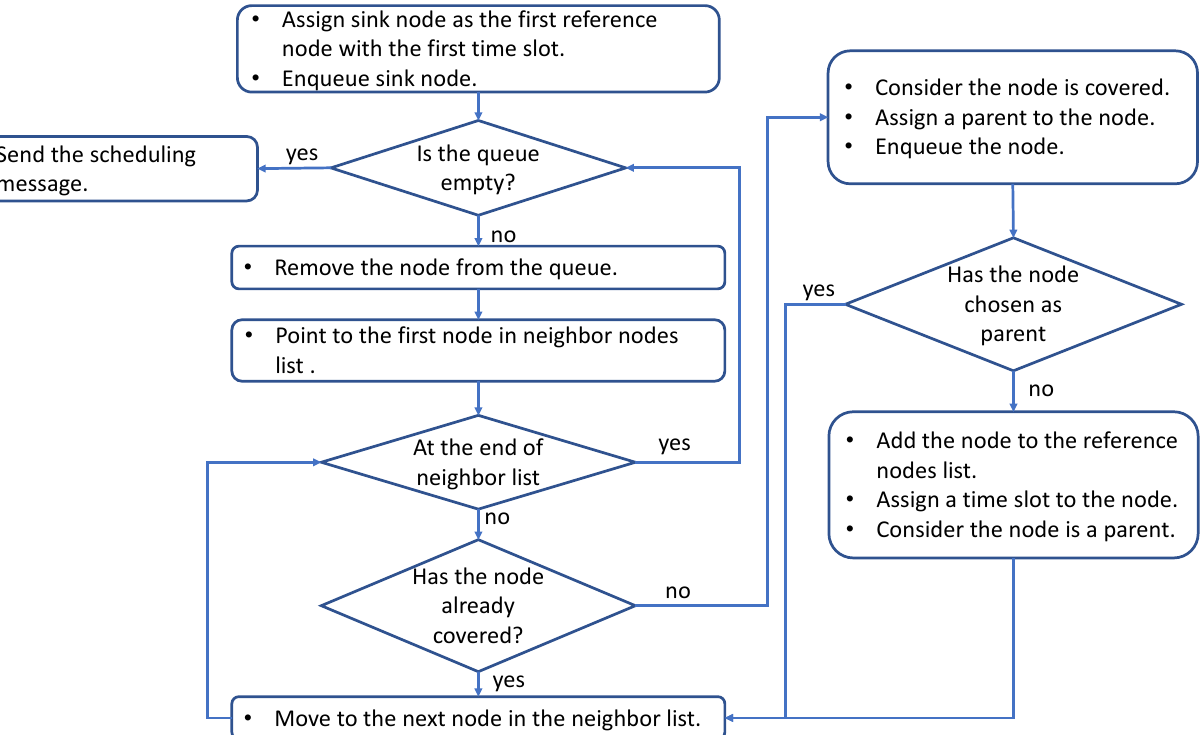
Figure 1. Scheduling process’s flow chart. Algorithm 1 : LPSRS pseudo-code for the scheduling process (sink node only)